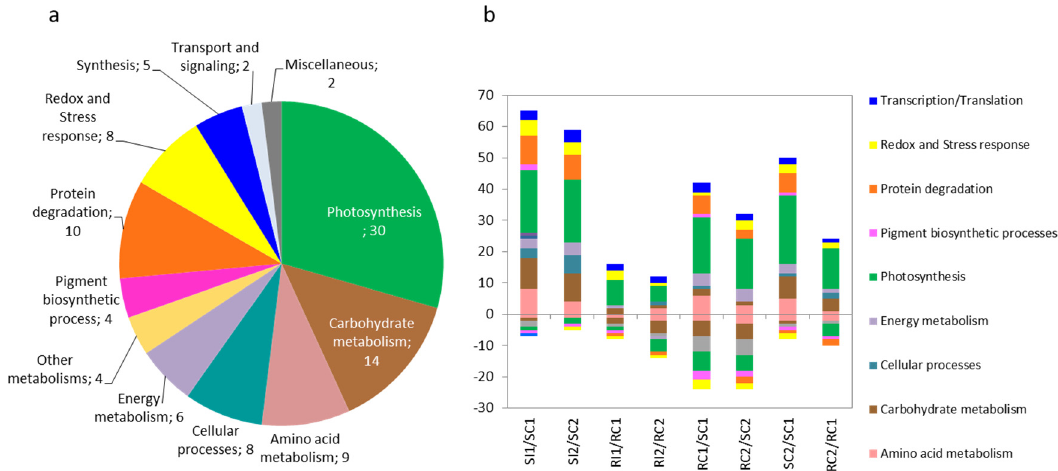
Figure 3. Functional groups of differential proteins. ( a ) Proteins up- or down-accumulating in response to B. fabae inoculation as grouped by functional category. ( b ) Susceptible (S) and resistant (R) genotype; control (C) and B. fabae inoculated (I); 6 hpi (1) and 12 hpi (2).